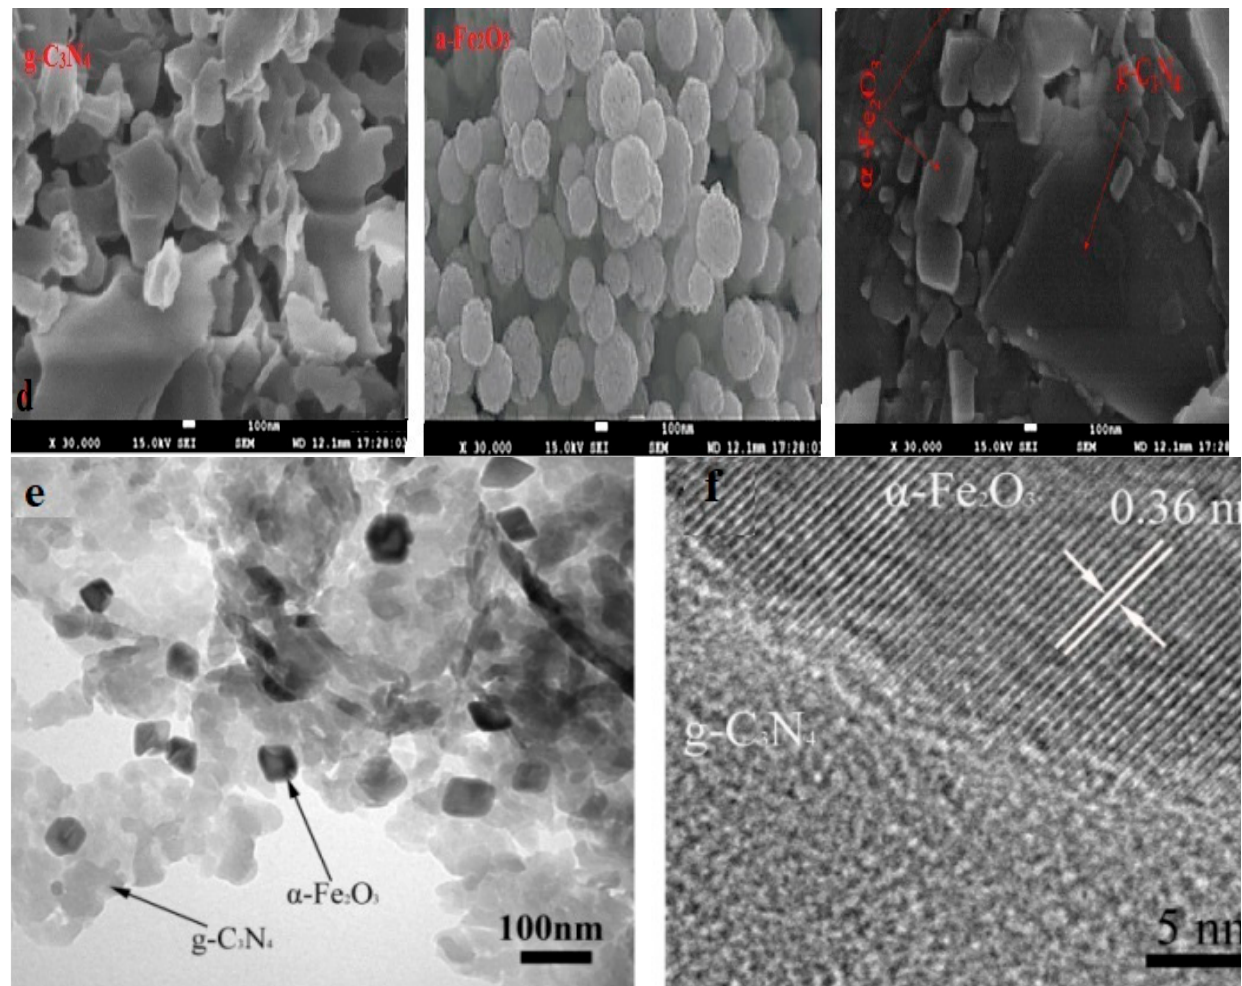
Figure 1. UV–Vis DRS spectra of α -Fe 2 O 3 /g-C 3 N 4 (reflectance spectra) ( a ); plot of transferred Kubelka-Munk versus energy of the light absorbed for g-C 3 N 4 , F, FG1, FG2, and FG3 ( b ); N 2 sorption isotherms ( c ); SEM images of g-C 3 N 4 , α -Fe 2 O 3 , and α -Fe 2 O 3 /g-C 3 N 4 ( d ); TEM image of α -Fe 2 O 3 /g-C 3 N 4 ( e ); HRTEM image of α -Fe 2 O 3 /g-C 3 N 4 ( f ).